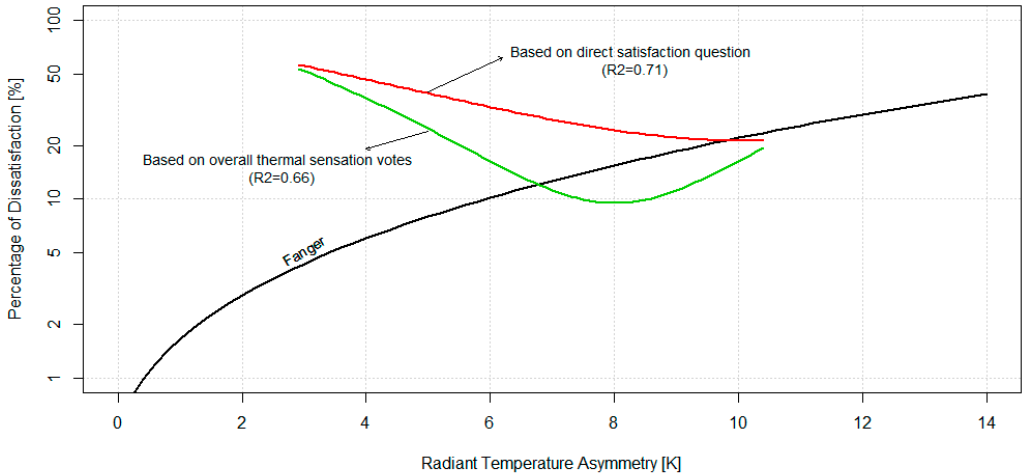
Figure 10. Regression lines comparing two methods of calculating the percentage of dissatisfied participants: (1) direct question about overall satisfaction; (2) assuming thermal sensation votes outside the middle three votes being a statement of dissatisfaction (following Fanger’s assumption); and the black reference curve was extracted from guideline curves given by Fanger and ASHRAE-55 [5,7,8].